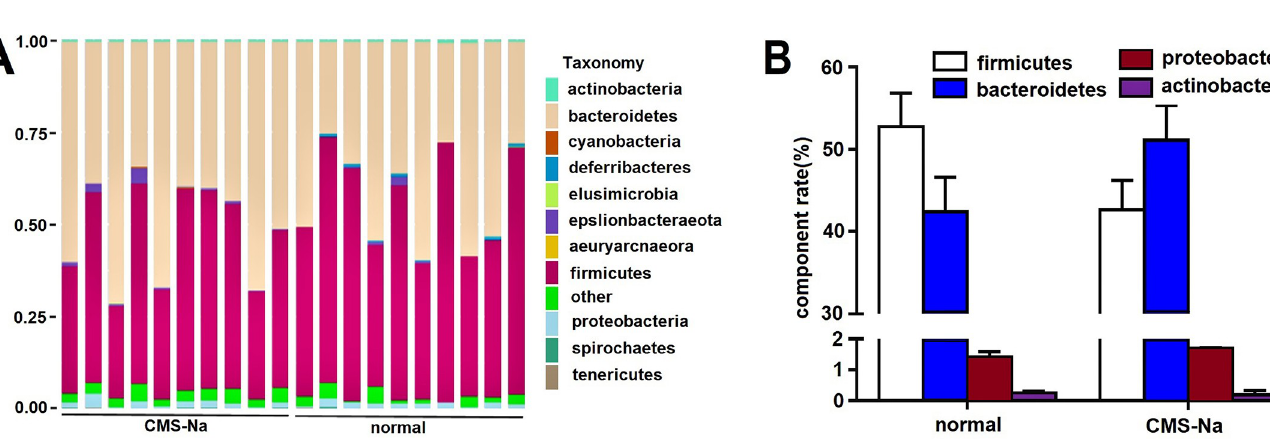
PLOS ONE | https://doi.org/10.1371/journal.pone.0257012 September 3, 2021 8 /